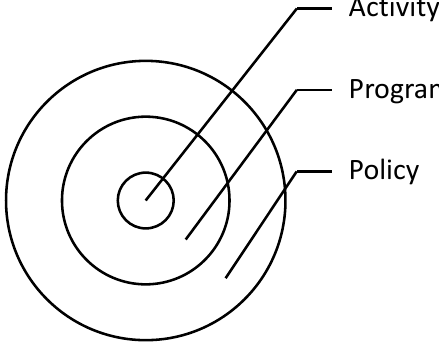
Figure 1. The relationship among the policy, program, and